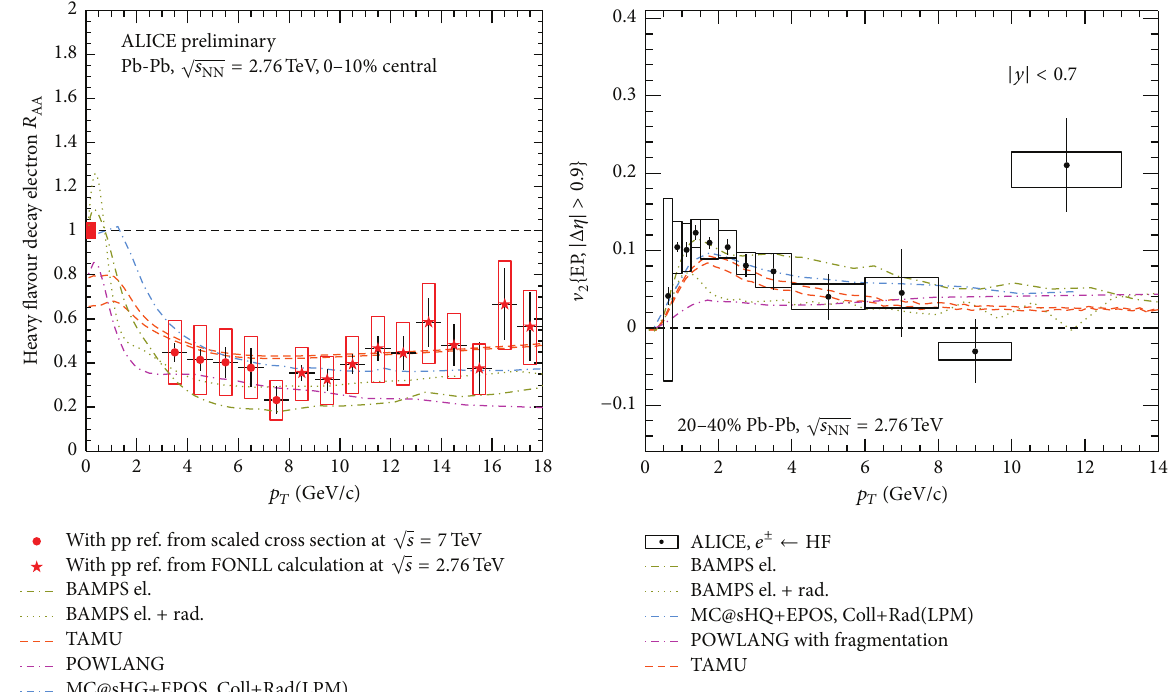
Figure 3: Measured V 2 and 𝑅 AA of NPE in Pb+Pb collision at 2.76 TeV [22–24]. Theoretical prediction for V 2 and 𝑅 AA of NPE are shown by lines